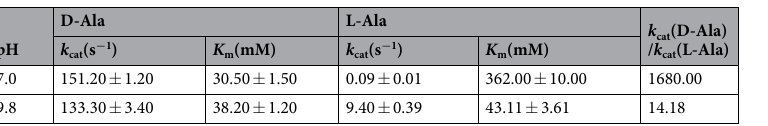
Table 3. Comparison of kinetic parameters of DAAO to D-Ala and L-Ala under different pH